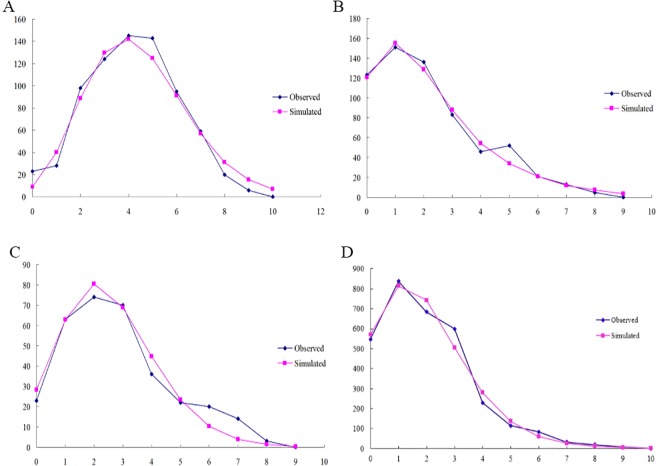
Observed and simulated mismatch distributions of the CC-NC-SC group.Sequence data are shown for (A) COI; (B) COII; (C) Cytb and (D) ITS2 region. The horizontal axis represents the number of pairwise differences, and the vertical axis represents the relative frequency.